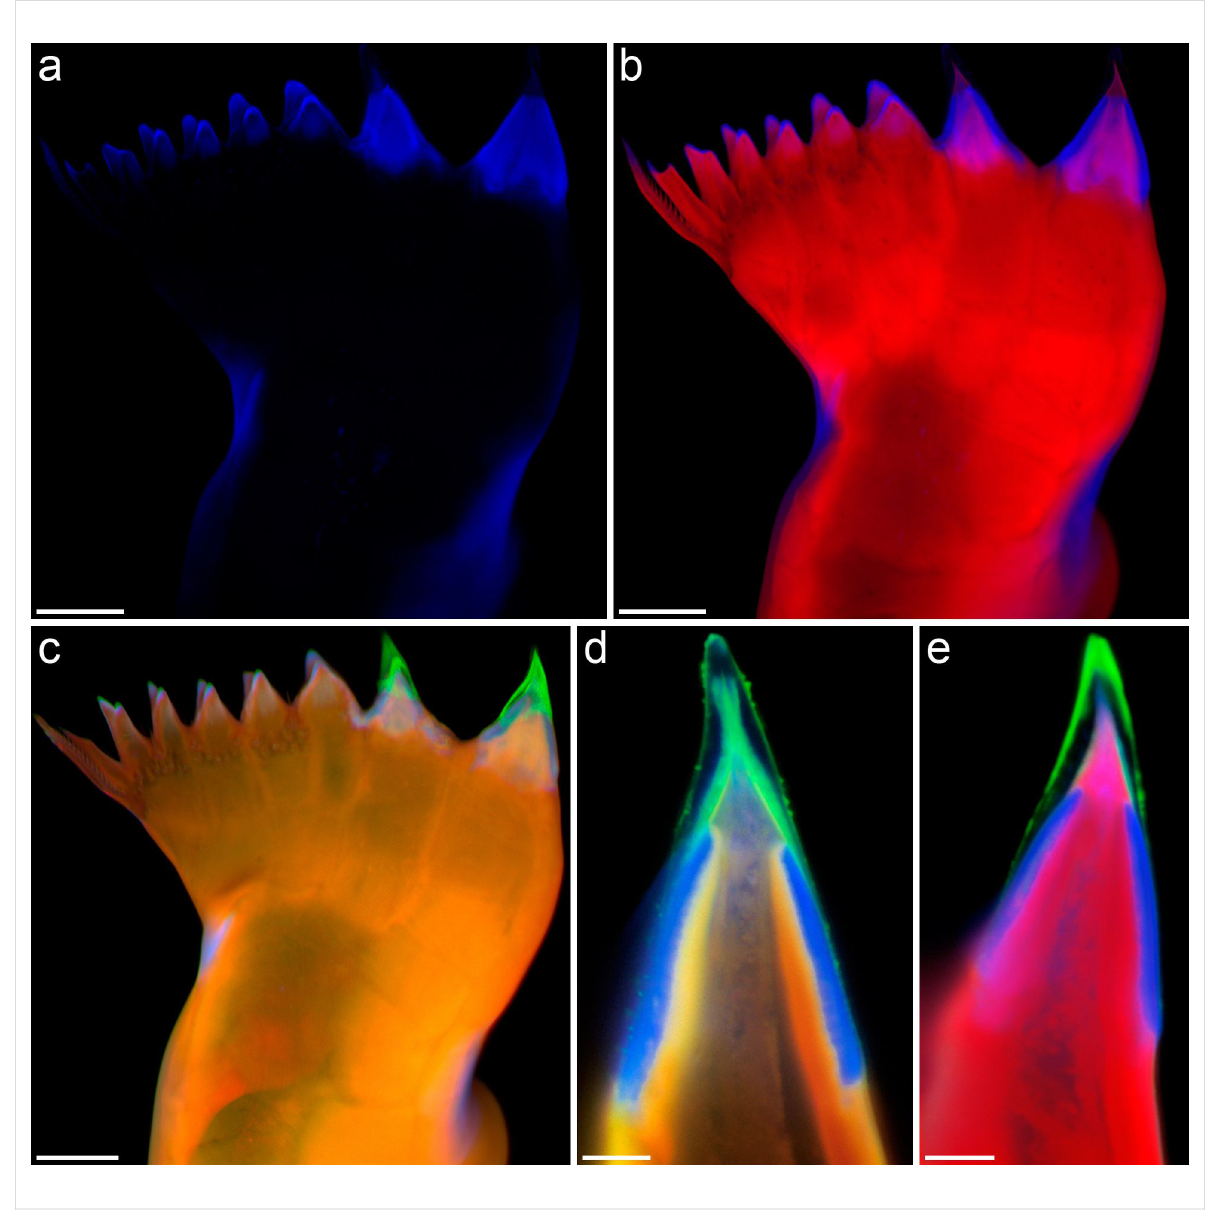
Figure 4: Mandibular gnathobases of female Centropages hamatus . (a–e) Confocal laser scanning micrographs (all cranial view) ([a–c] maximum intensity projections showing the whole gnathobase; [d, e] 1-µm-thick optical sections through the ventral tooth). (a) Distribution of resilin. (b) Chitinous exoskeleton (red) and resilin-dominated structures (blue). (c–e) Chitinous exoskeleton (orange, red), resilin-dominated structures (blue, light blue) and silica-containing structures (green). Scale bars = 20 µm (a, b, c), 5 µm (d, e). Figure adapted with permission from